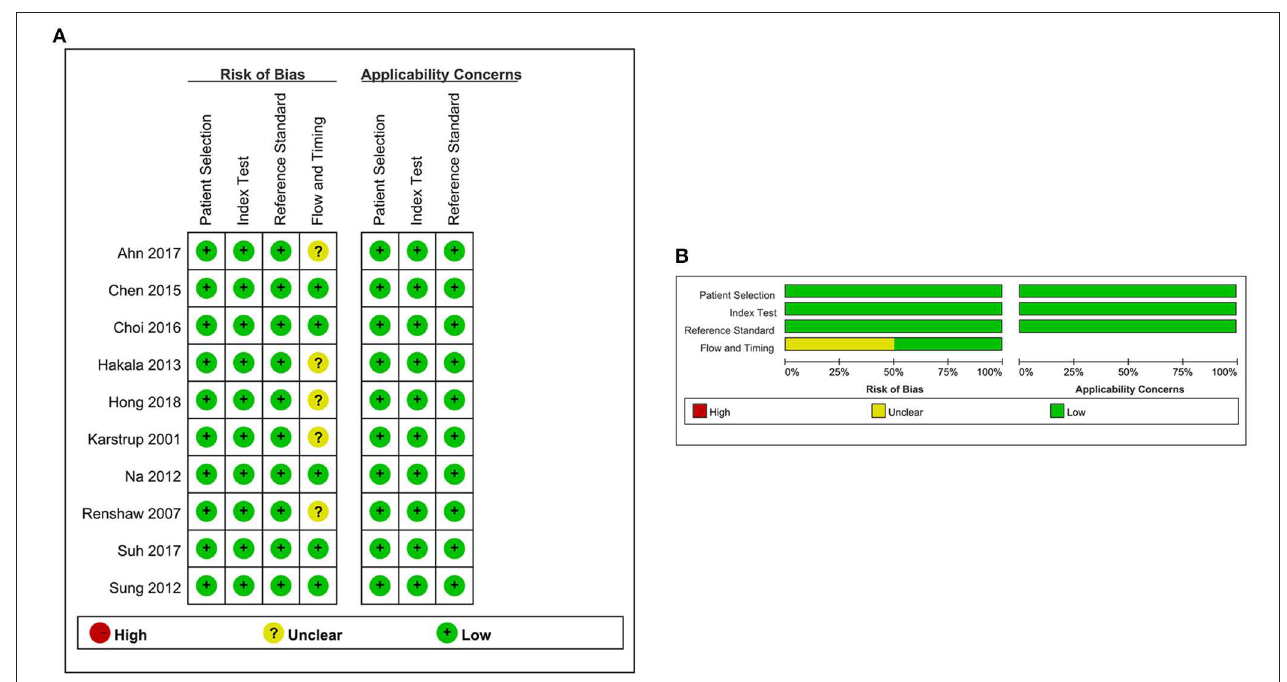
Frontiers in Endocrinology |